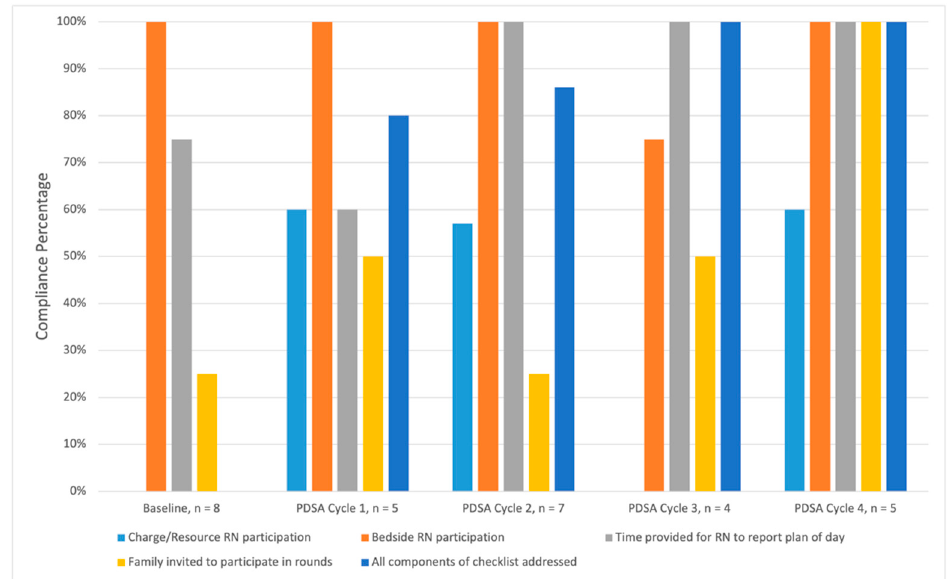
Figure 4. Plan–Do–Study–Act Cycle Data. Pediatric Intensive Care Unit multidisciplinary rounds were observed by study team members to assess for key elements listed in legend. y -axis demon- strates compliance percentage for each element during a cycle. x -axis demonstrates each element conducted in cycles over time. Baseline data were acquired from November 2019–December 2019. Cycle 1 data were acquired January 2020. Cycle 2 data were acquired February 2020. Cycle 3 data were acquired March 2020. A two-year follow-up was completed in March 2022, listed as Cycle 4. PDSA = Plan–Do–Study–Act.